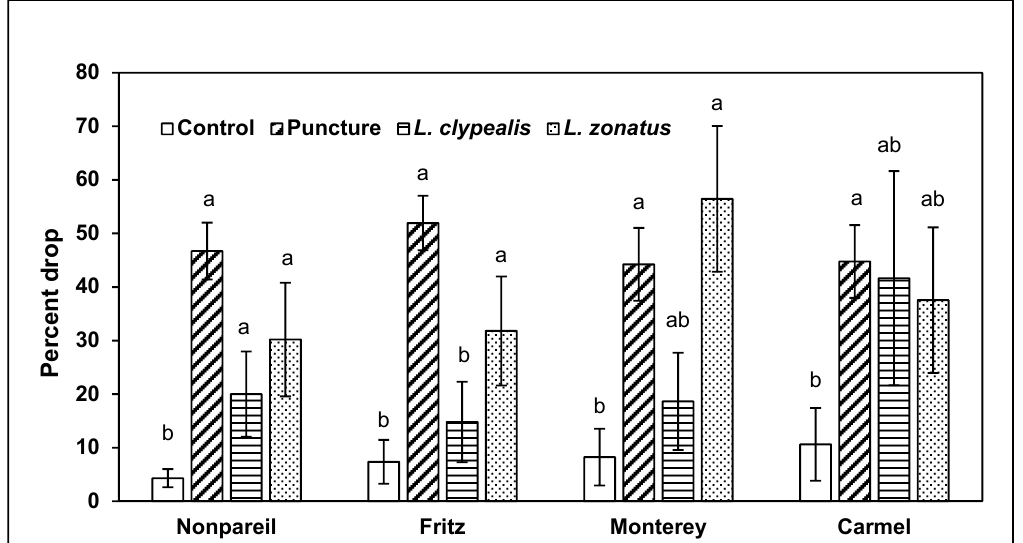
Figure 1. Mean ( ± SE) almond drop in four experimental treatments in four almond varieties in Figure 1. Mean (± SE) almond drop in four experimental treatments in four almond varieties in 2014. 2014. Within each variety, there was a significant di ff erence among treatments (Kruskal–Wallis). Within each variety, there was a significant difference among treatments (Kruskal–Wallis). Pairwise Pairwise comparisons were by Steel–Dwaas tests ( p < 0.05), and significant di ff erences are indicated by comparisons were by Steel–Dwaas tests ( p < 0.05), and significant differences are indicated by di ff erent different letters.